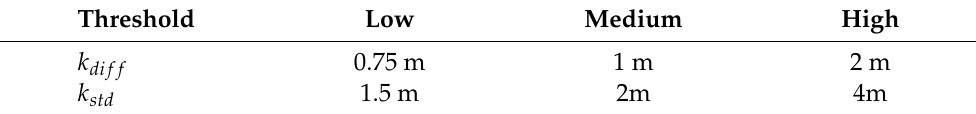
Table 1. Thresholds for Equations (1) and (2) depending on bathymetry confidence.